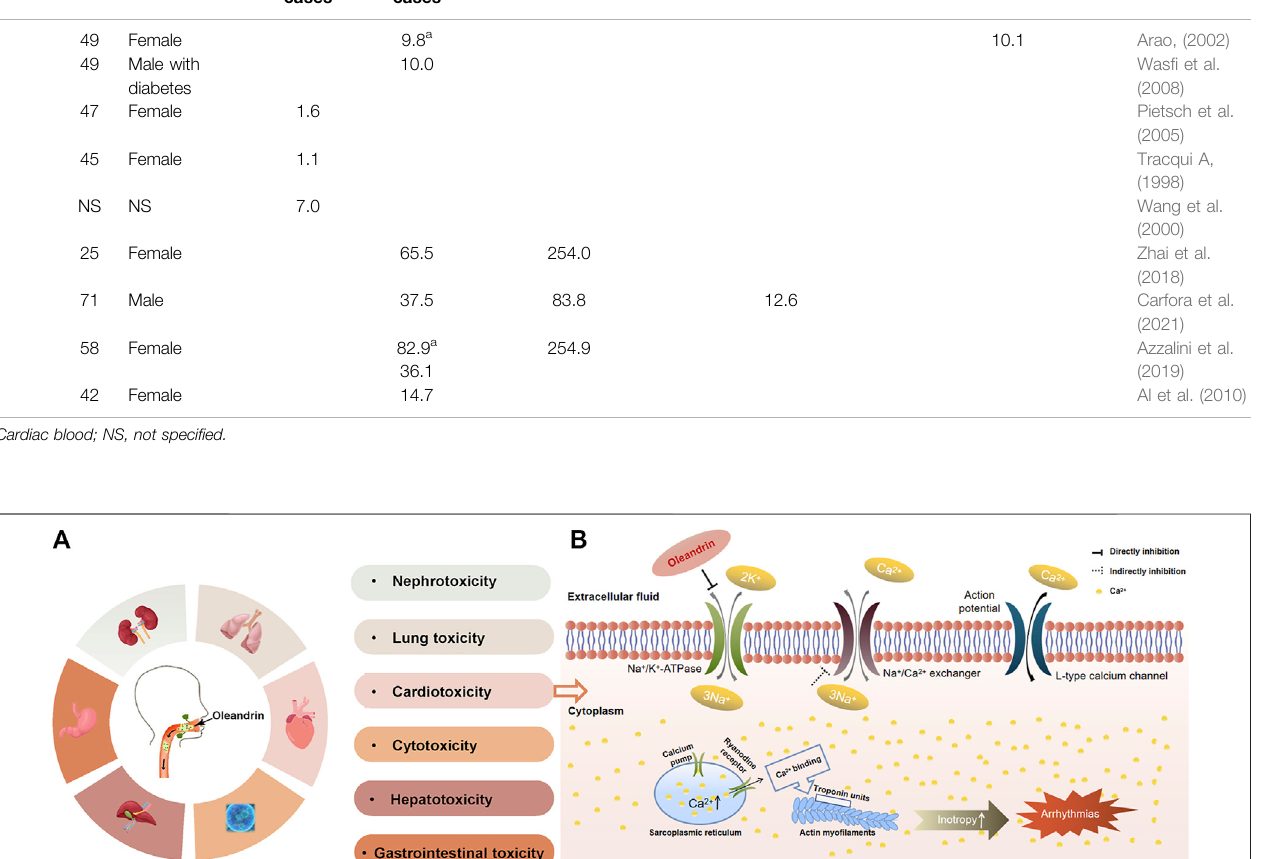
Frontiers in Pharmacology |